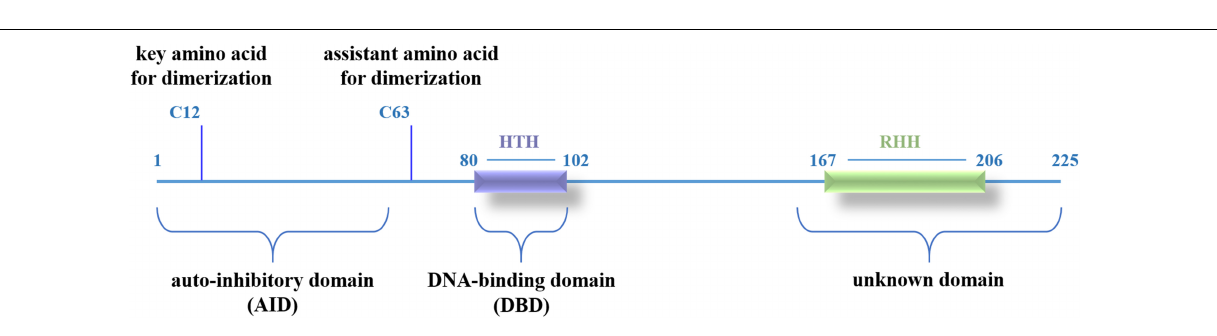
FIGURE 7 | A hypothetical model for the functional domains of